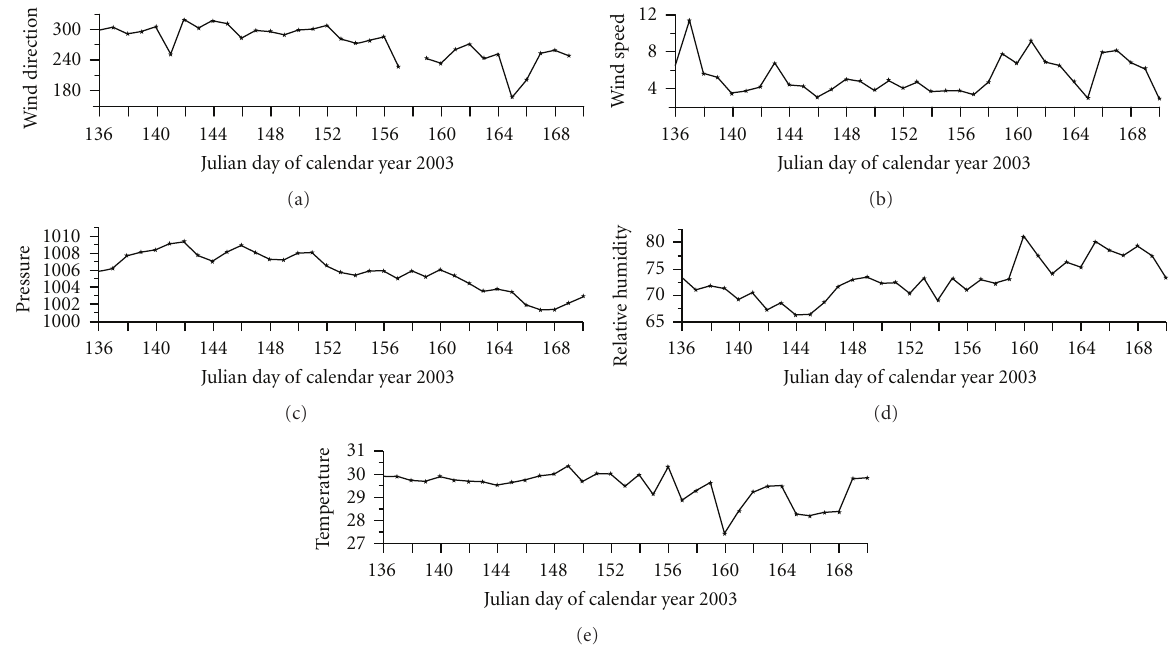
Figure 2: Daily averaged values of air temperature, relative humidity, atmospheric pressure, wind speed, and direction during the cruise period.